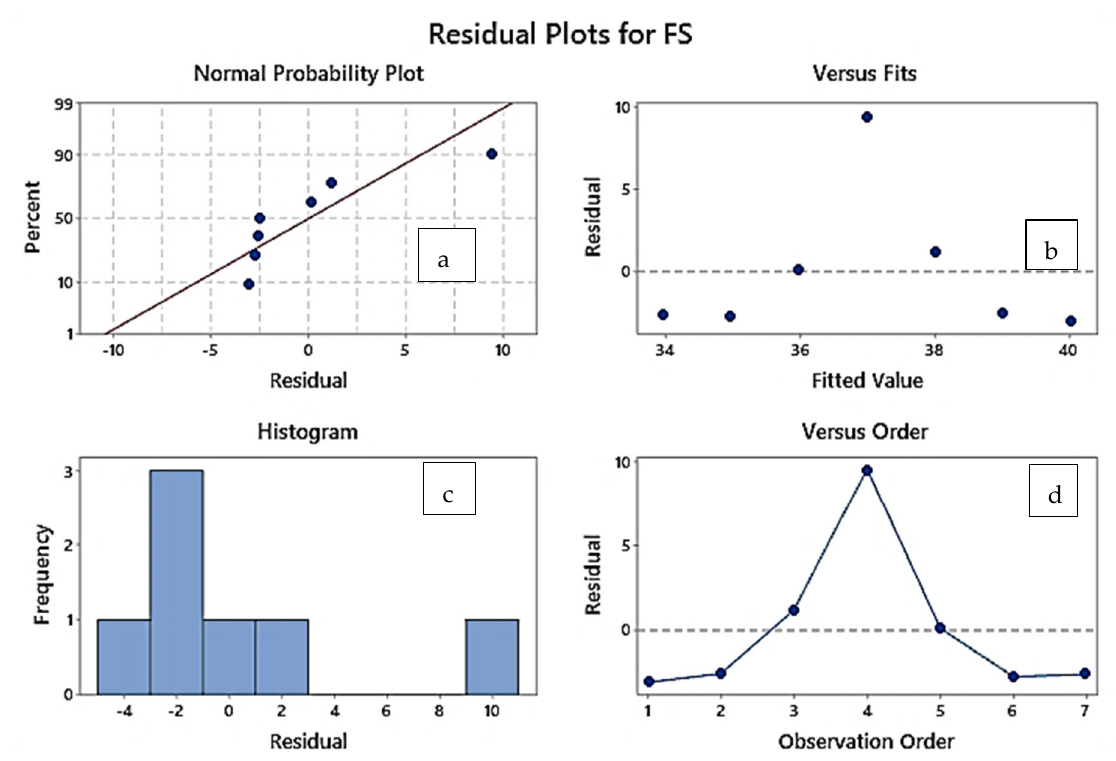
Figure 5. Residual plot for ATA samples based on a linear regression model. ( a ) Normal probability plot, ( b ) Fit vs. residual plot. ( c ) Frequency vs. residual plot. ( d ) Residual vs. observation order plot.